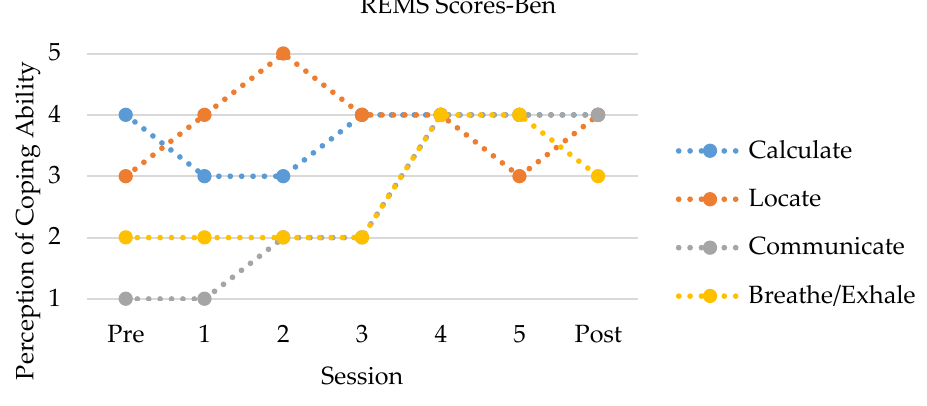
Figure 2. Child responses to coping strategies through the duration of EMBRace.